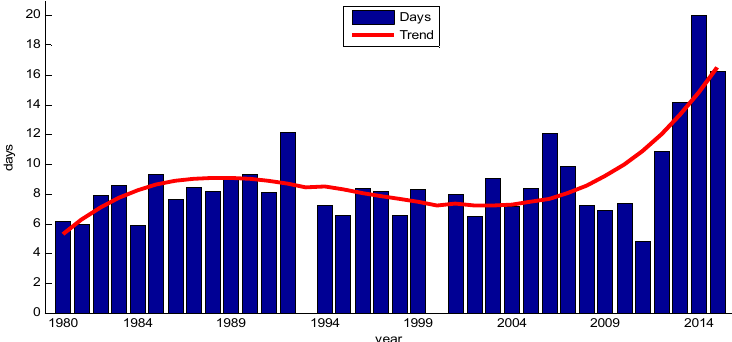
Figure 2. The number of haze-fog days in January from 1980 to 2015 (blue bar) and its trend (red line). To clarify the relationship between the 500 hPa geopotential height fields in the